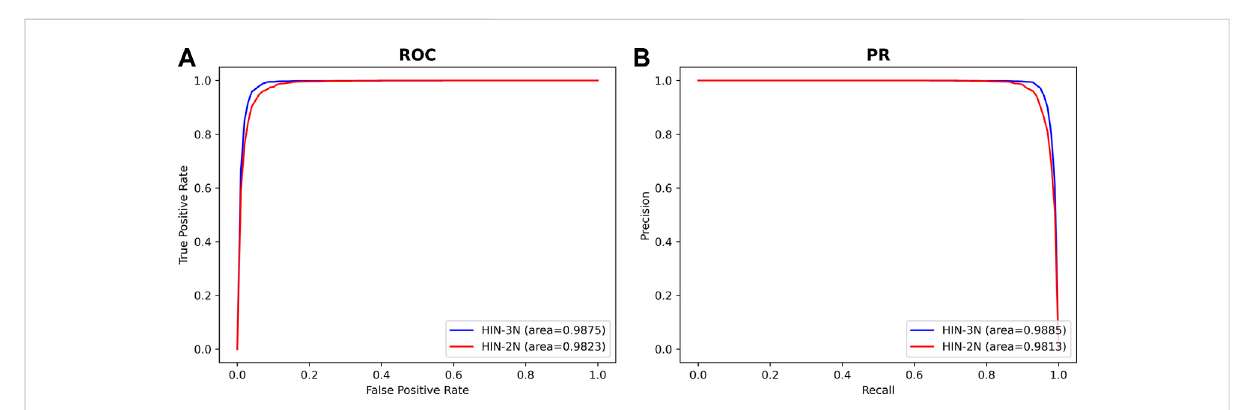
FIGURE 6 The ROC curves (A) and PR curves (B) on different heterogeneous networks.